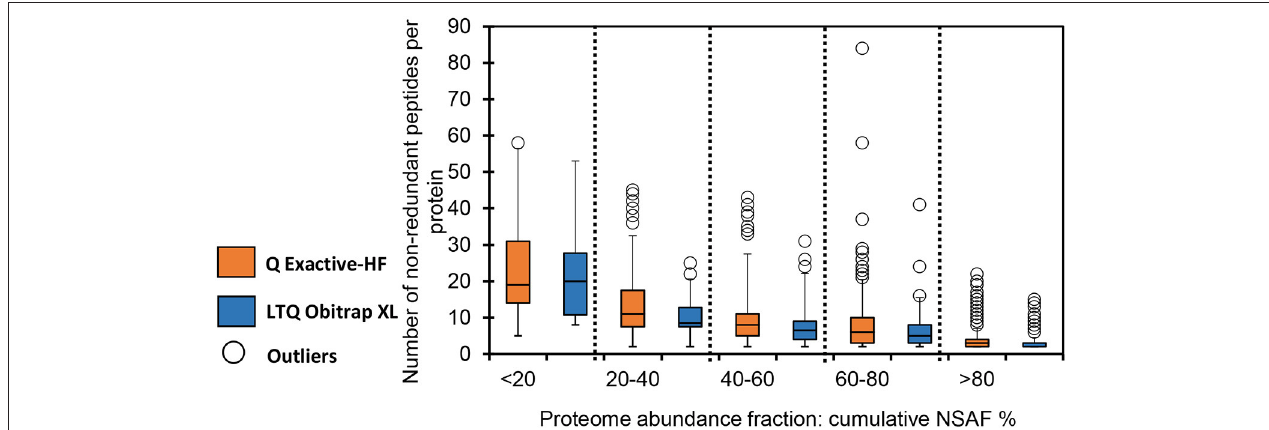
FIGURE 2 | Distribution of the number of non-redundant peptides per protein based on their abundance in the whole proteome. Boxes extend from the first to the third quartile; the bold segment indicates the median value; the whiskers extend to the most extreme data points, no more than 1.5 times the interquartile range. Data points at more than 1.5 times the interquartile range are represented by empty circles (outliers). Orange: Q-Exactive HF dataset; blue: LTQ Orbitrap XL